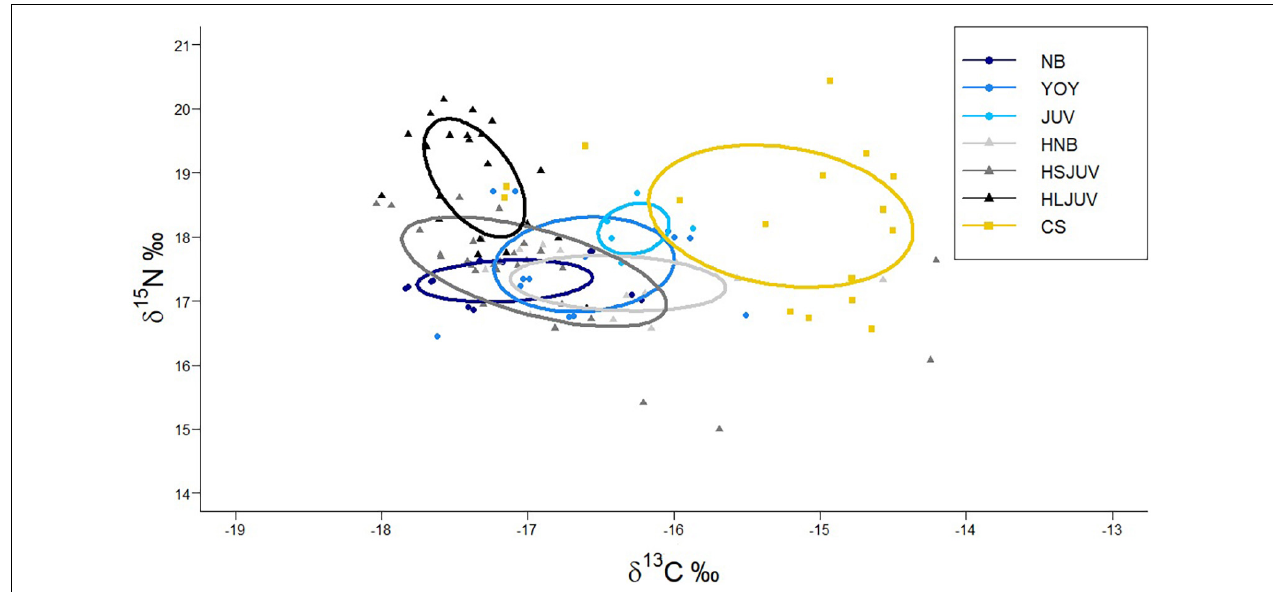
FIGURE 6 | Isotopic niches of different life stages of different size classes of immature white sharks, smooth hammerhead sharks and copper sharks sampled in Bahía Sebastián Vizcaíno. NB, newborn white sharks; YOY, young of the year white sharks; JUV, juvenile white sharks; HNB, newborn hammerheads; HSJUV, small juvenile hammerheads; HLJUV, large juvenile hammerheads; CS, copper